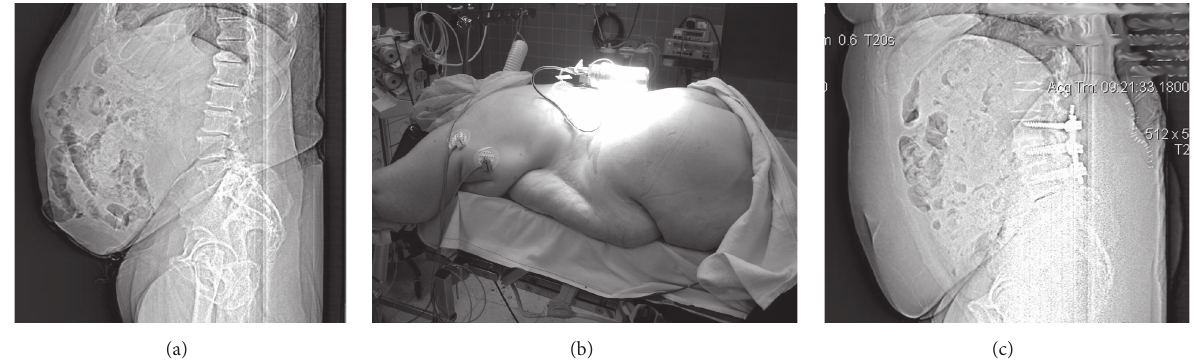
Figure 2: Example of obese patients with BMI > 30. (a) Presurgical CT scout of a 64y.o. male patient with BMI 34.6. (b) Severely obese 59 y.o. female patient with BMI 37.1 positioned on the OR-table. (c) CT scout of the patient shown in (c) after two-level